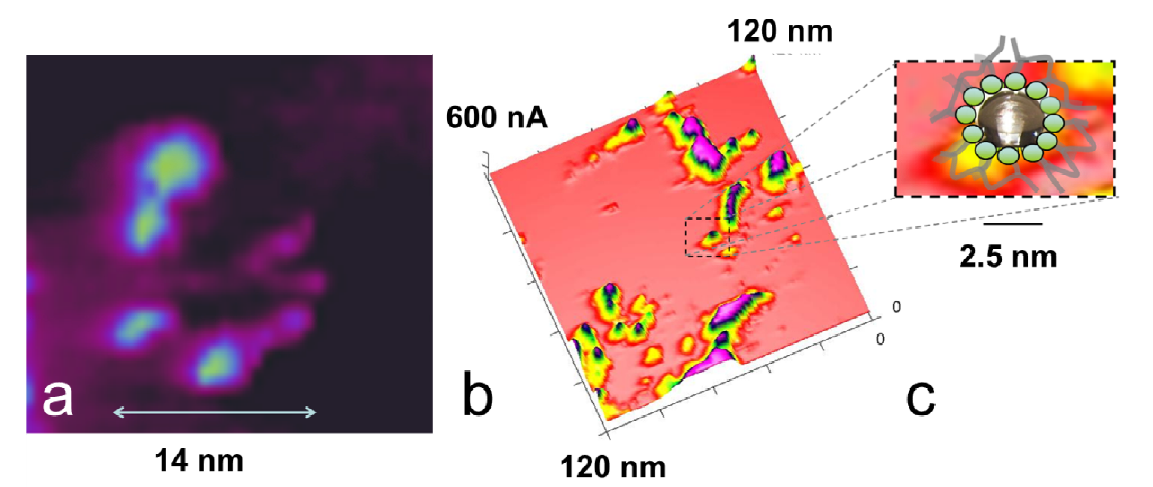
Figure 14. ( a ) AFM PeakForce-TUNA ® ionic current image of activated Nafion ® 112 with a spiral nanostructure with partly connected current spots. ( b ) Larger area of same ionic current measurement in ( a ) with linear current structures as well as single current spots. ( c ) A schematic drawing of an inverted micelle with a size of 2.5 nm according to the model of Schmidt-Rohr is superimposed onto a single current